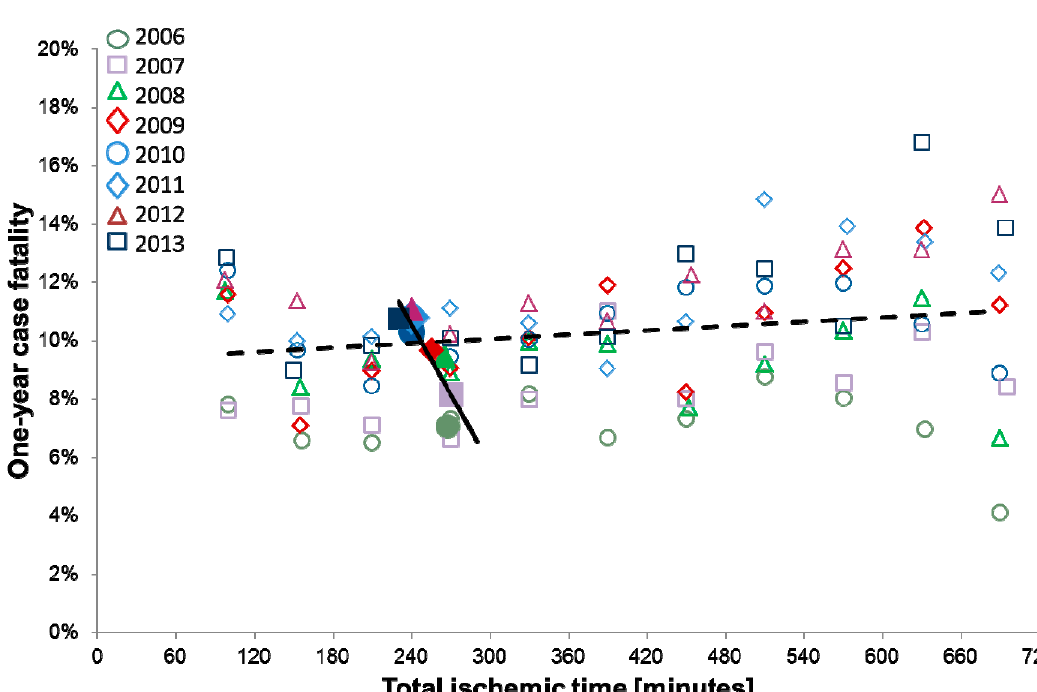
Figure 4. Relation between one-year case fatality and total ischemic time. Open boxes—relation between one-year case fatality and patient-specific total ischemic time within years; Solid boxes— relation between one-year case fatality and annual total ischemic time across years. Linear trend lines represent visual relation; dashed line for patient-specific trend and continuous line for annual trend.